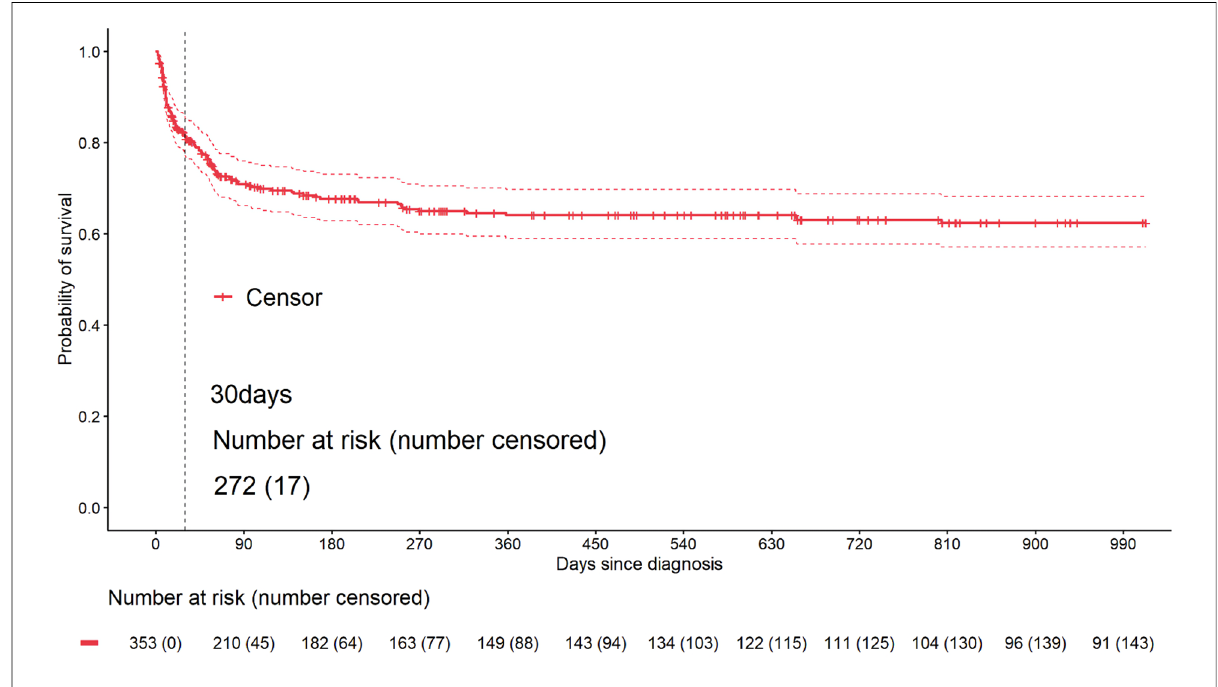
FIGURE 5 Kaplan – Meier survival curves for 353 children with